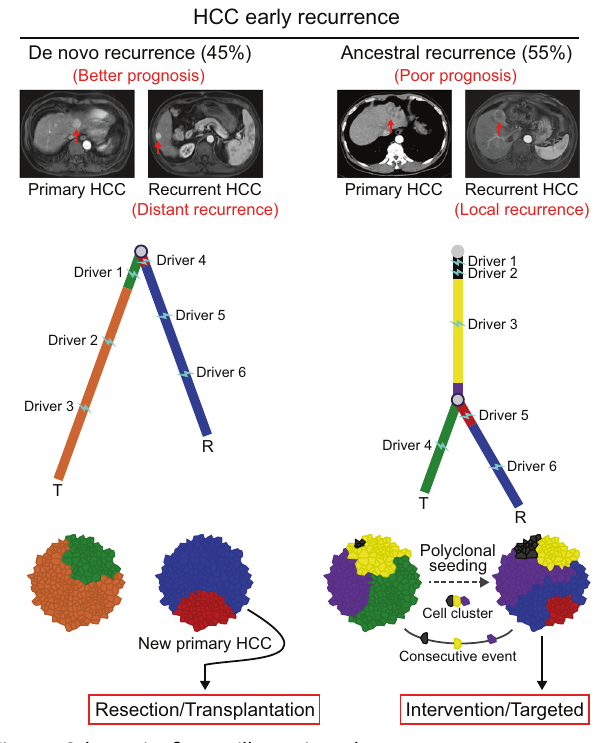
Fig. 9 Schematic fi gure illustrating the recurrence pattern and evolutionary trajectory of HBV-related hepatocellular